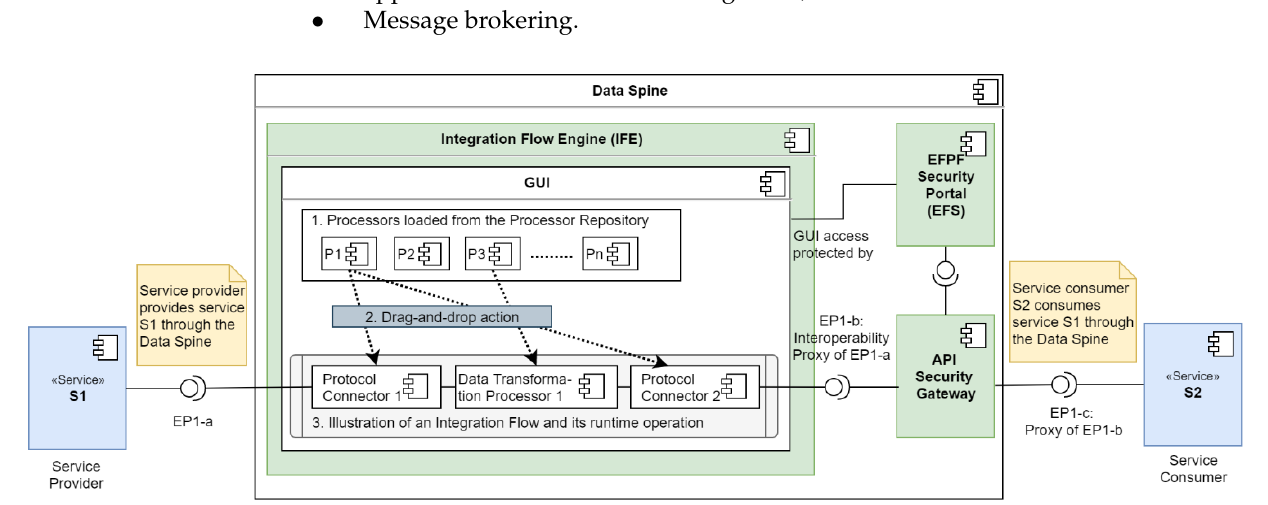
Figure 6. Illustration of the creation and runtime operation of an integration flow.